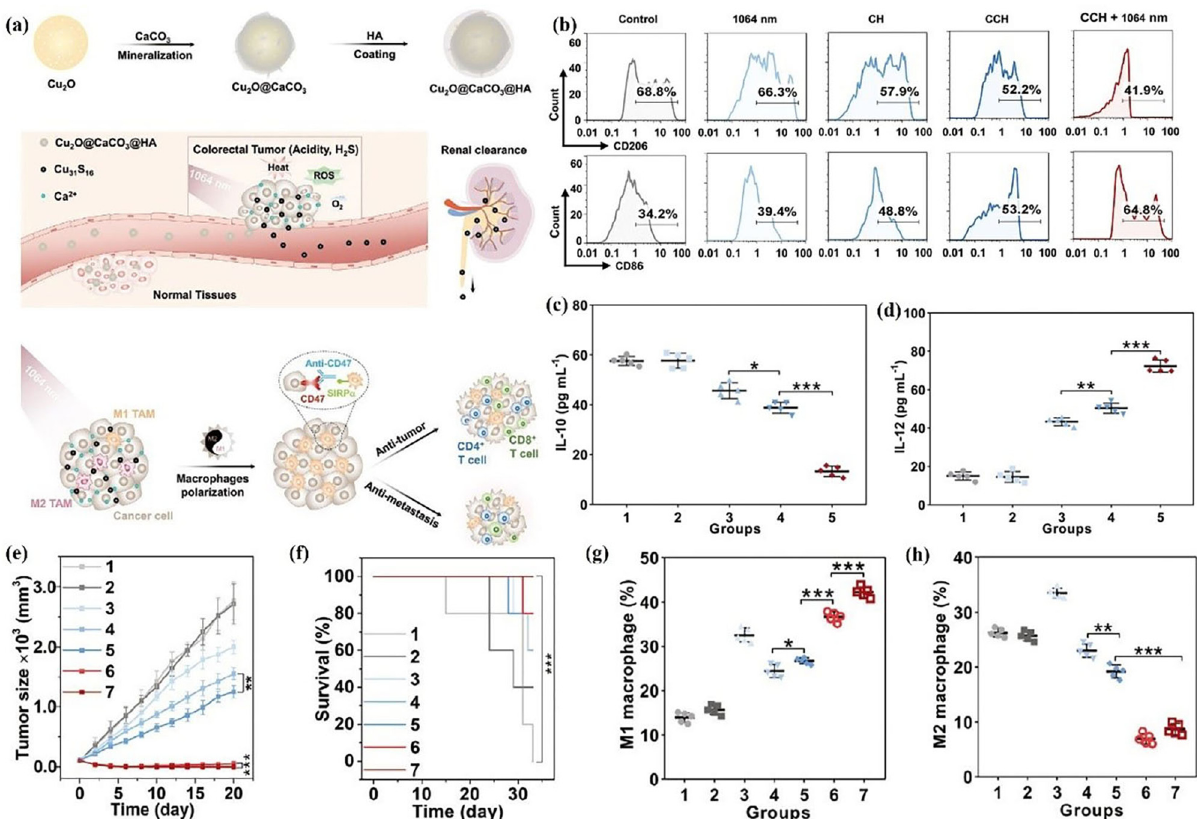
Figure 11: ( a ) Systemic illustration of the synthesis, bio - decomposition, antitumor immune responses, and renal clearance of CCH. ( b ) The fl ow cytometry of CD206 ( M2 macrophage marker ) and CD86 ( M1 macrophage marker ) expression in di ff erent treatments. ( c and d ) Secretion levels of IL - 10 and IL - 12 in the supernatant after di ff erent treatments. ( e and f ) The tumor sizes and survival rate after di ff erent treatments. ( g and h ) M1 and M2 macrophage percentages in the tumors. Groups: ( 1 ) control, ( 2 ) 1,064 nm, ( 3 ) anti - CD47, ( 4 ) CH, ( 5 ) CCH, ( 6 ) CCH + 1,064 nm, and ( 7 ) CCH + 1,064 nm + anti - CD47. Reprinted with permission from Ref. [ 116 ] ; Copyright © 2020 Wiley -